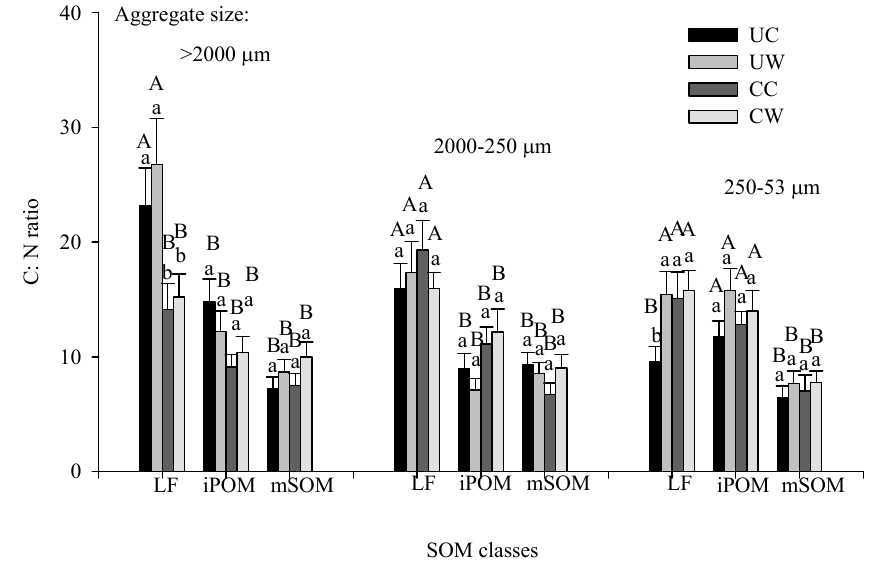
Fig. 4. C:N ratios of LF, iPOM, and mSOM of aggregate size classes under four treatments after nine years of warming and clipping. Values followed by a different lowercase letter are significantly different within SOM classes among treatments of each aggregate size. Values followed by a different capital are significantly different among SOM classes under treatments of each aggregate size. See Fig. 1 for